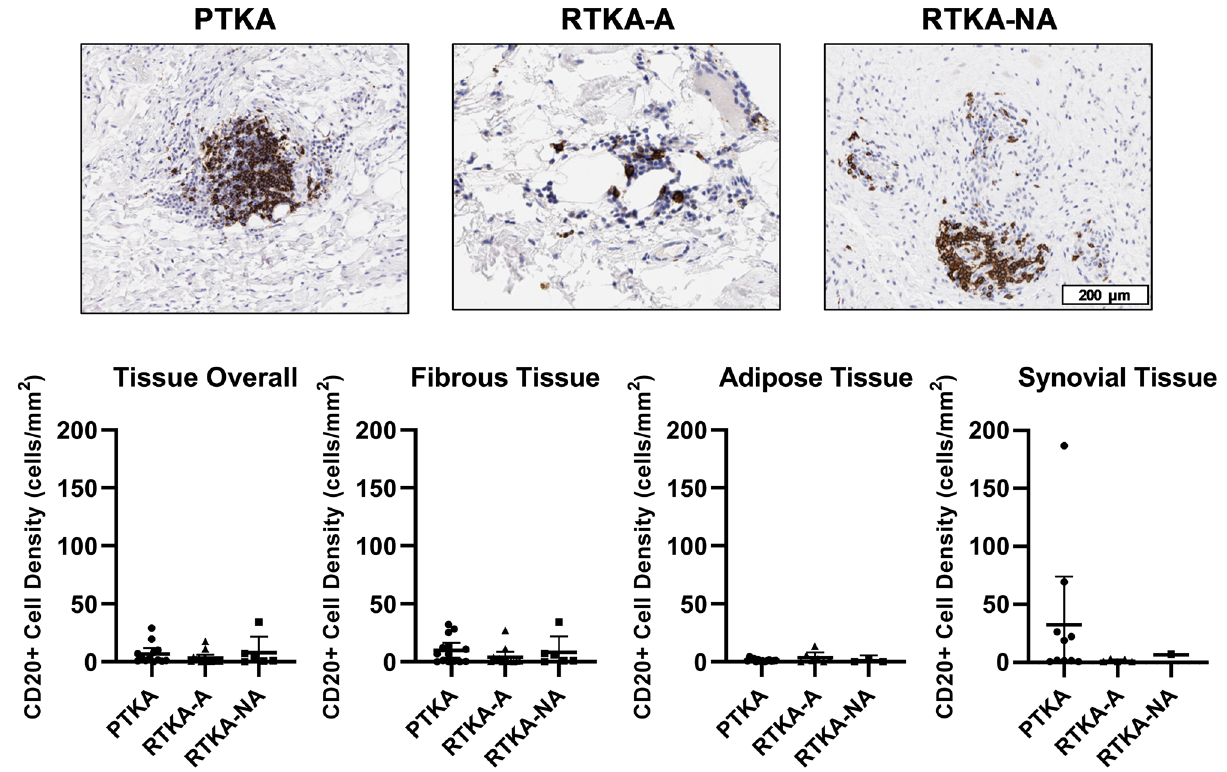
Figure 8. Quantification of B-cells cells in periarticular knee tissue. Tissue density of CD20 + B-cells per mm 2 in the whole tissue and in the fibrotic, adipose and synovium regions with representative images from the three groups (PTKA = primary TKA, RTKA-A = arthrofibrosis, RTKA-NA = non-arthrofibrosis). The graphs depict mean B-cells density (CD20 + cell/mm2) ± standard deviation, with each data point representing one patient. The scale bar applies to all images in this